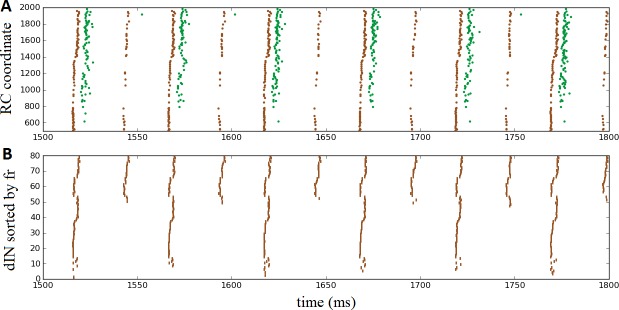
Oscillatory activity on one side of the body after removal of commissural connections.(A) Raster plot of spiking activity during swimming, showing dINs (brown) and motoneurons (green) on the left side of the spinal cord after removal of commissural connections. (B) The same dIN spiking activity as in (A), but with the spike trains sorted vertically based on increasing firing rate. In both cases, activity is shown between 1500 and 1800 ms post-stimulation, when the system has settled down into a stable oscillatory state.